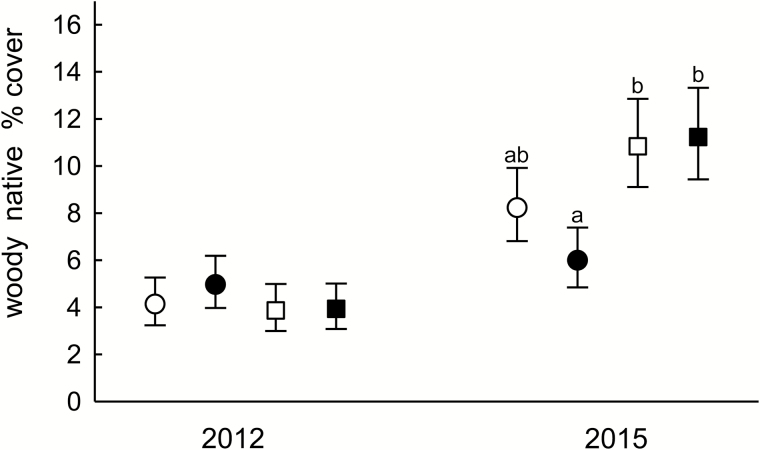
Fall cover (%) of woody native species in the herb layer within six suburban forests in central New Jersey, in fenced plots (square) or in plots with deer access (circles) with (filled symbols) or without (open symbols) Microstegium vimineum seed addition. Data are combined across all forests and are means ± 95 % CI (back-transformed from logits) of 55–56 plots. Different letters above the mean indicate significant differences within a year (Tukey–Kramer adjusted P < 0.05).